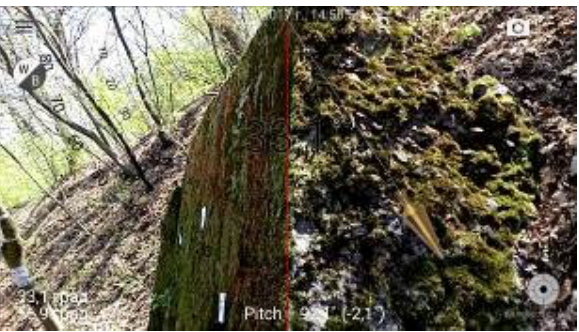
Figure 10. Example of inclination measurement